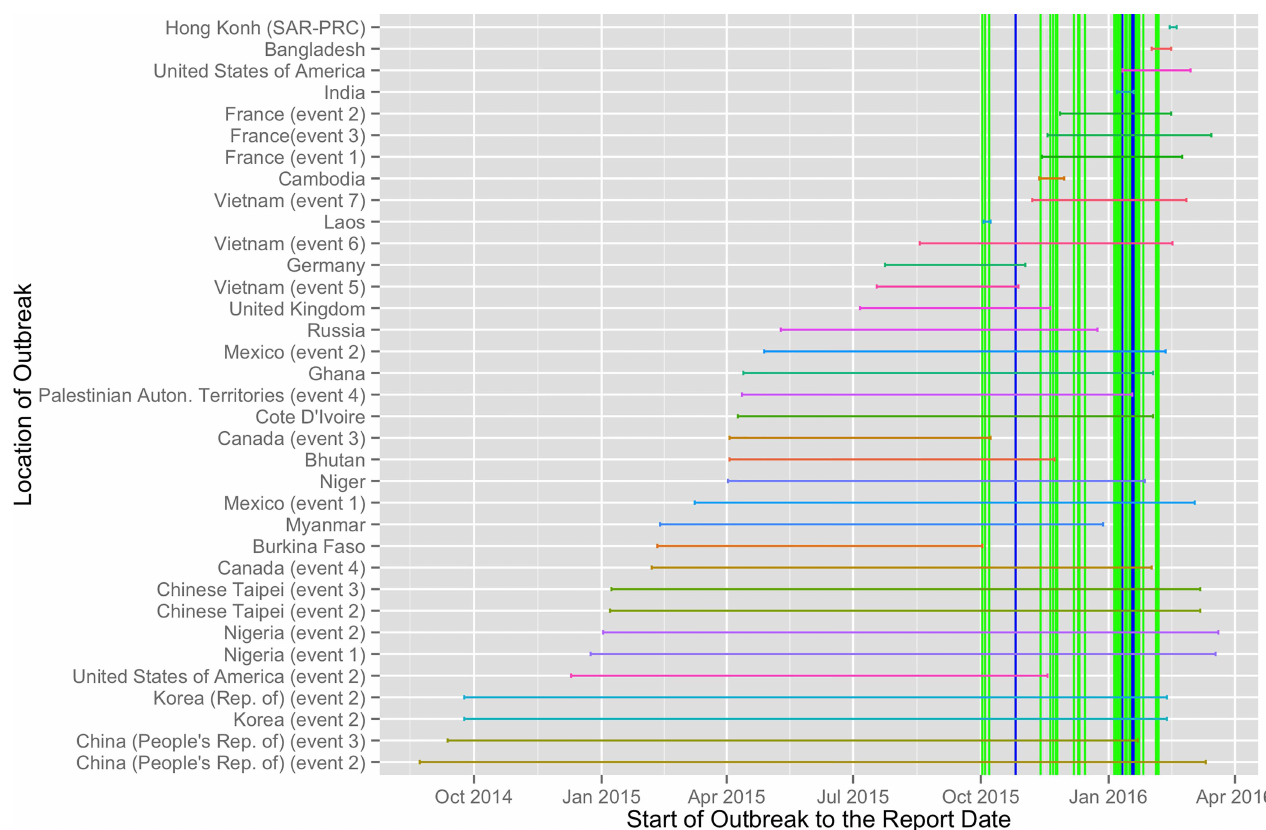
Fig 9. Official OIE outbreaks vs outbreaks identified on Twitter, blue vertical lines indicates dynamic method, green static method.